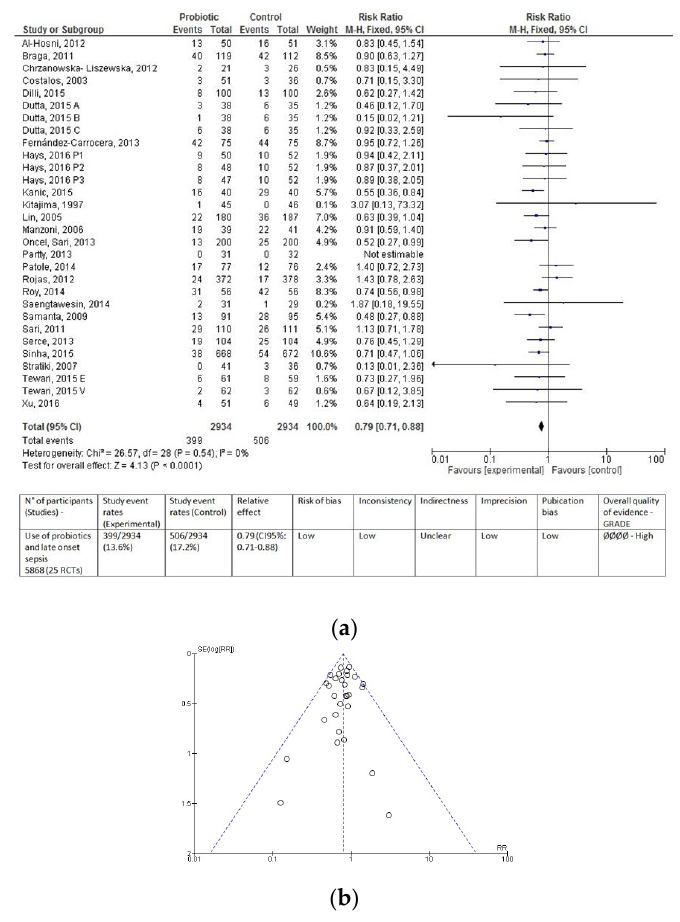
Figure 2. Forest plot ( a ) and funnel plot ( b ) of the included studies. The forest plot shows the association between the use of probiotics and late onset sepsis in the overall population of preterm infants. The evaluation of the overall results of the meta ‐ analysis according to the GRADE approach is reported below the forest plot. The funnel plot does not show any clear visual asymmetry. M ‐ H: Mantel–Haenszel method; RR, risk ratio; CI, confidence interval.